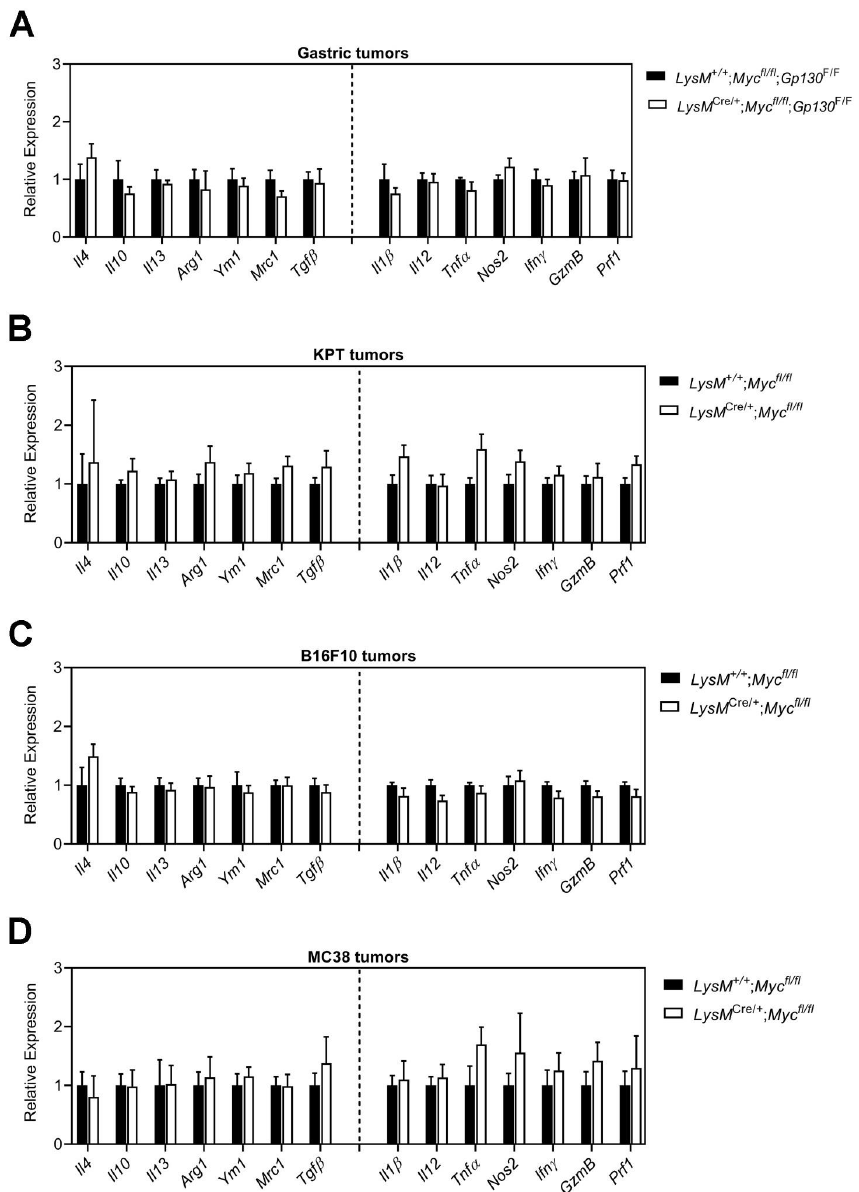
Figure 3. Inhibition of Myc signaling in TAMs does not reduce tumor immune suppression. qPCR analysis on ( A ) Gp130 F/F , ( B ) KPT, ( C ) B16F10 and ( D ) MC38 tumors of LysM +/+ ; Myc fl/fl and LysM Cre/+ ; Myc fl/fl hosts for genes associated with immune suppression (i.e., Il4, Il10, Il13, Arg1, Ym1, Mrc1, Tgfβ ) or immune activation (i.e., Il1β, Il12, Tnfα, Nos2, Ifnγ, GzmB, Prf1 ). n = 4 mice per group. Data represent mean ± SEM.